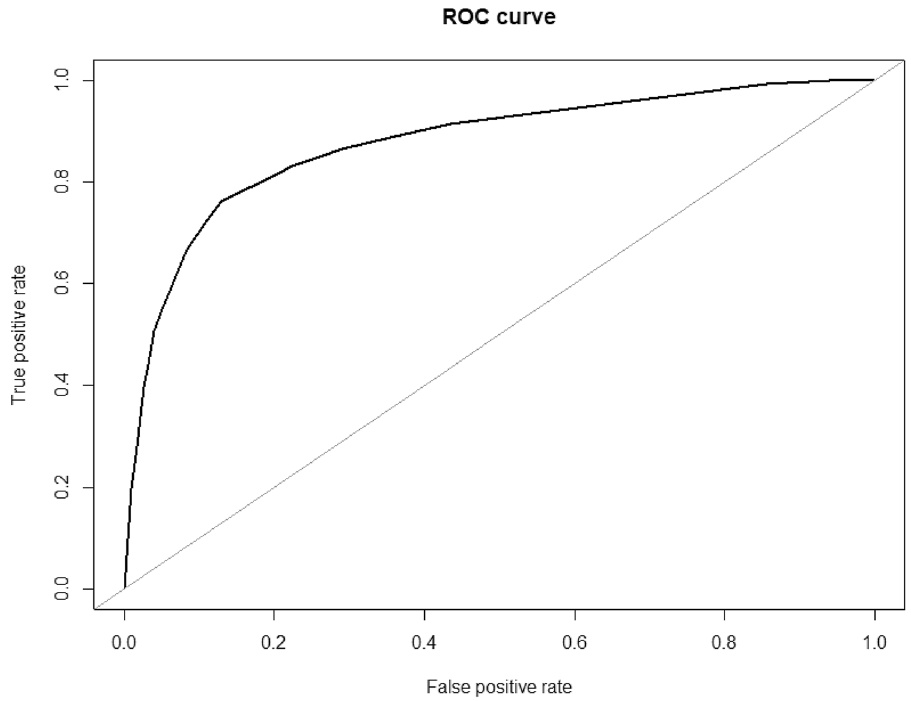
Figure 1. ROC (receiver operating characteristics) curve of data (train:test = 80:20) prediction after ROSE oversampling method. AUC was 0.89. R program version 3.6.3 (The R Foundation for Statistical Computing, Vienna, Austria) was used in creating diagram.